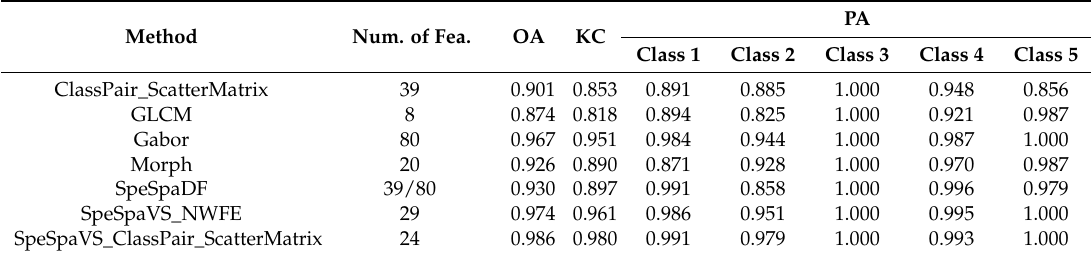
Table 4. Performance of the methods investigated in the paper on data set